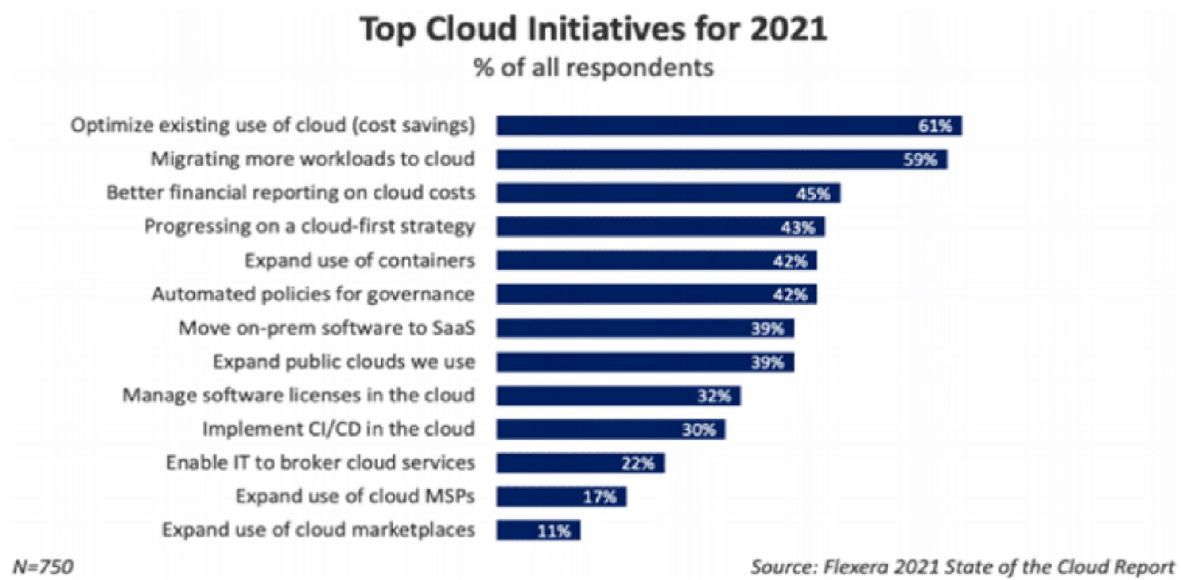
Fig. 2 Flexera’s state of the cloud report